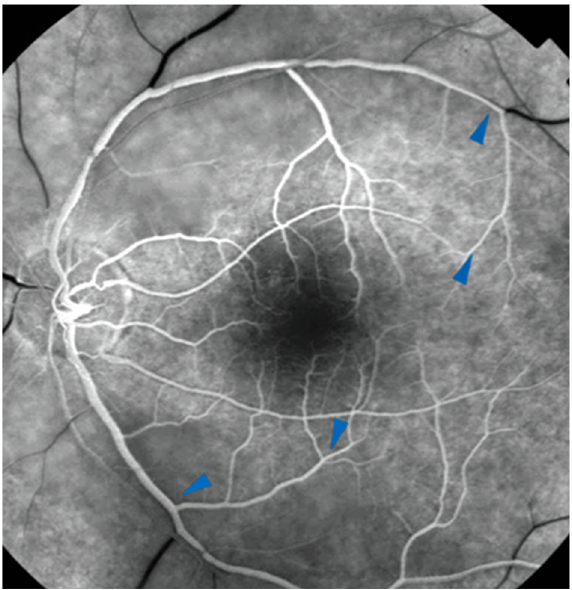
Figure 2. Fluorescein angiography shows interruption of flow in the central retinal artery, regular filling of the cilioretinal artery and late retrograde filling in the central retinal vein.